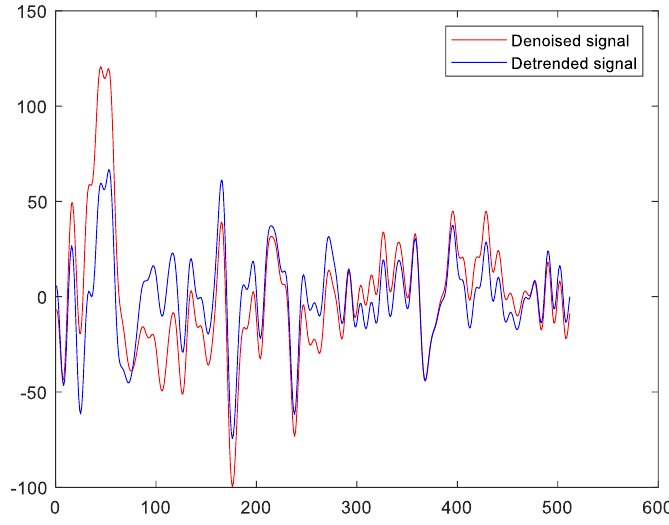
Figure 5. The denoised signal and the detrended signal.